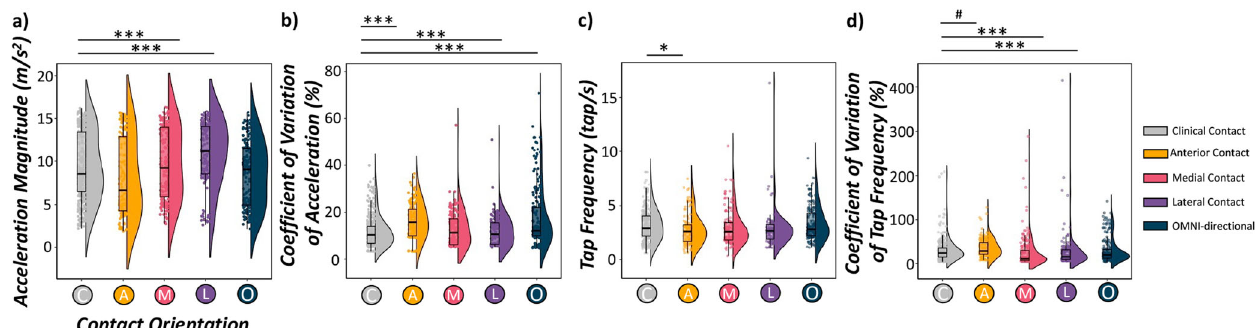
Fig. 1 STN-DBS contact orientations effect accelerometer metrics of fi nger tapping. Single-trial accelerometer metrics of fi nger tapping (e.g., acceleration magnitude, tap frequency, variability) were quanti fi ed using a fi xed-threshold algorithm and subjected to LMEs of each behavioral metric as a function of contact orientation (factor with 5 levels), controlling for acquisition order. Raincloud plots include a combined box plot (box edges: fi rst 25th percentile quartile to third 75th percentile quartile; center line: median; data minima/maxima: whisker length), histogram distribution and individual scatter points of each accelerometer metric. Right-handed fi nger tapping yielded smoother movement pro fi les (i.e., slower single-trial general acceleration ( a ), lower acceleration variability per tap ( b ), increased